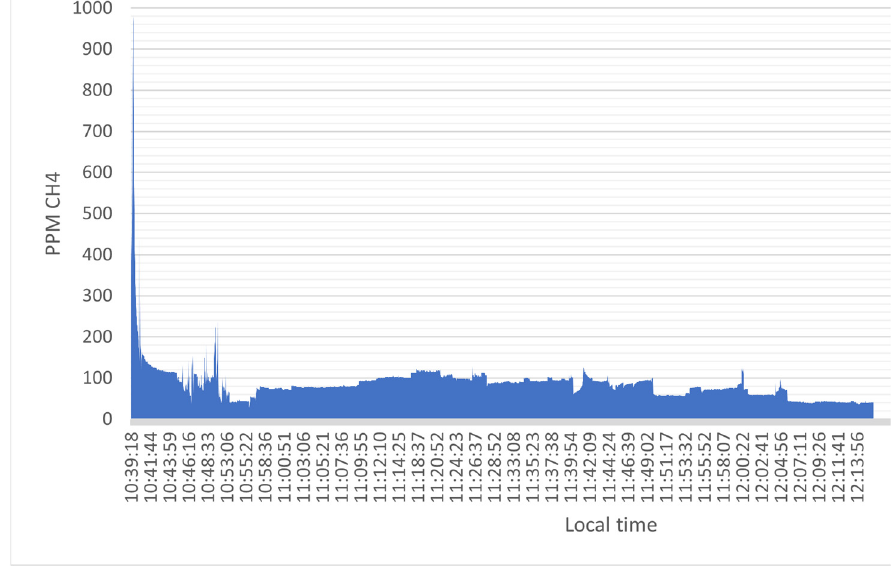
Figure 12. Gas sensor MQ4 data, ppm values as a function of time in Kariotiskes landfill site. The measured values were generalised, interpolated and overlayed on an ortophoto- graphic map, shown in Figure 13.